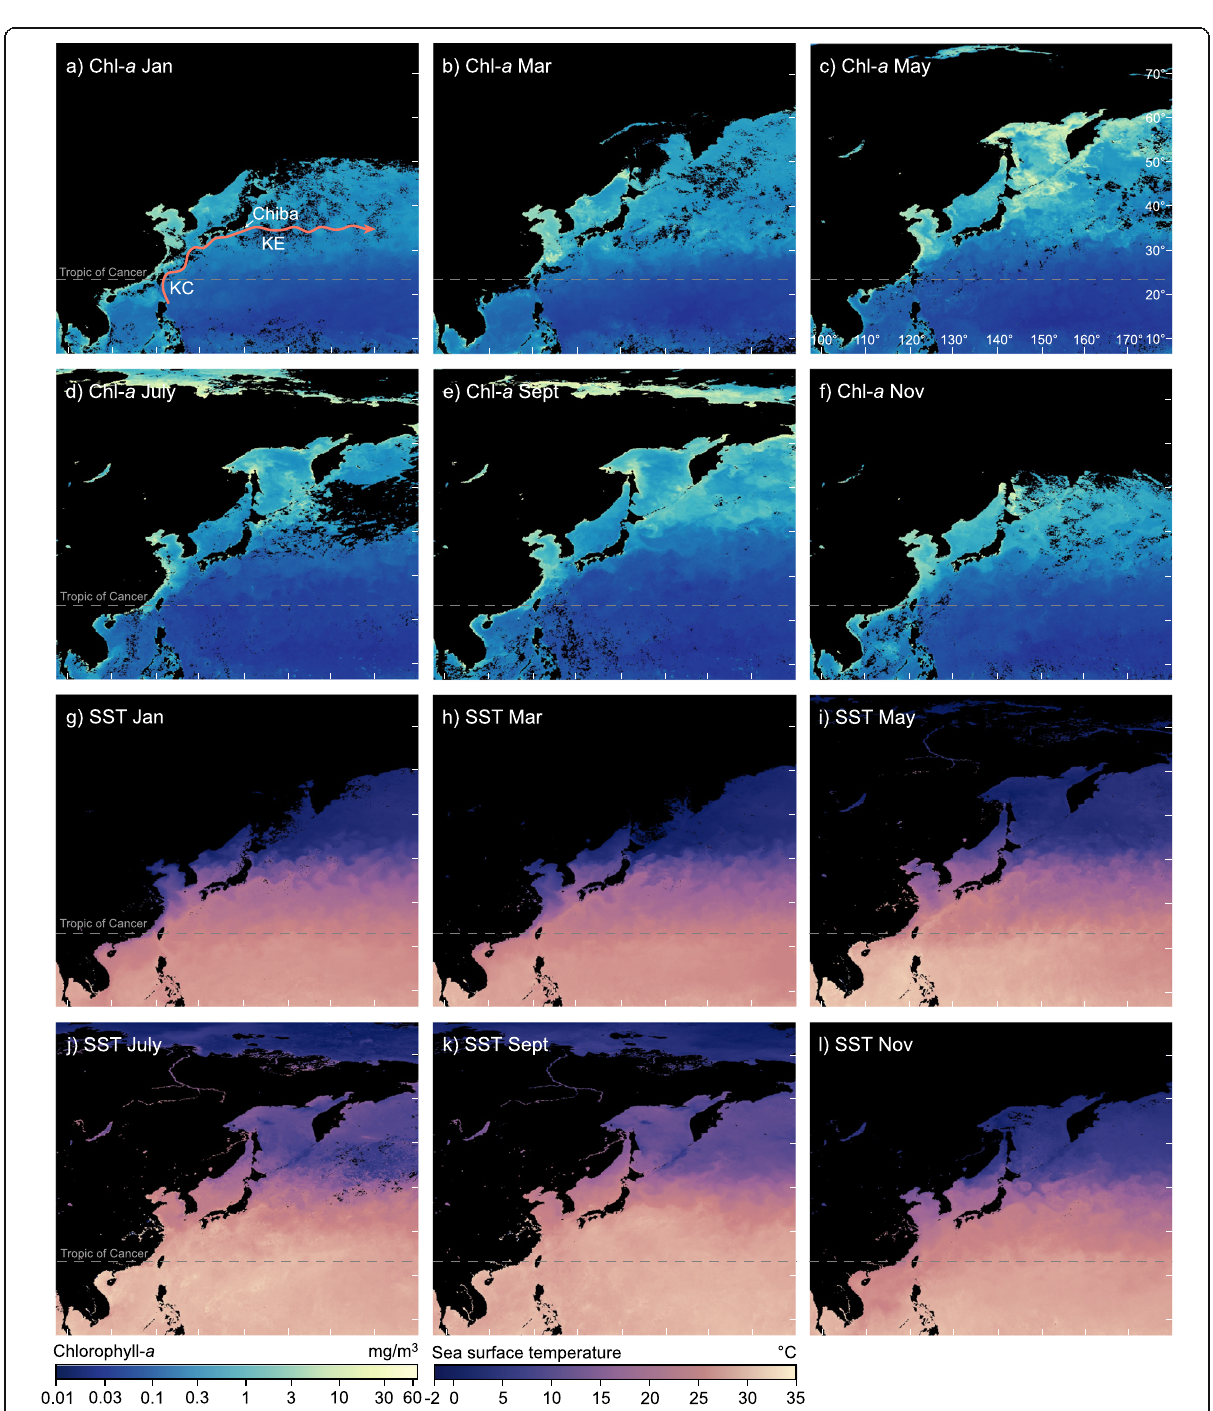
Fig. 16 Monthly chlorophyll- a (Chl- a ) concentrations and monthly sea-surface temperature (SST) for the western North Pacific in 2019 based on satellite observations. a – f Chlorophyll- a concentrations as a measure of primary (phytoplankton) productivity. The generalized positions of the Kuroshio Current (KC) and Kuroshio Extension (KE) are given in a . The position of the Kuroshio Extension Front (KEF; Fig. 15) is evident from sharply enhanced productivity around and north of ~ 30° N; greatest productivity in the mid-latitudes east and north of Chiba is during the boreal spring (March – May) with a subdued rise in the autumn (September – October). g – l Sea-surface temperature; the KEF moves only slightly northwards during summer – autumn but the latitudinal gradient across the KEF lessens significantly in summer with considerable northward diffusion of warm water during July – September. Note mesoscale eddies pinching off along the KEF and advecting heat northwards. NASA Earth Observations